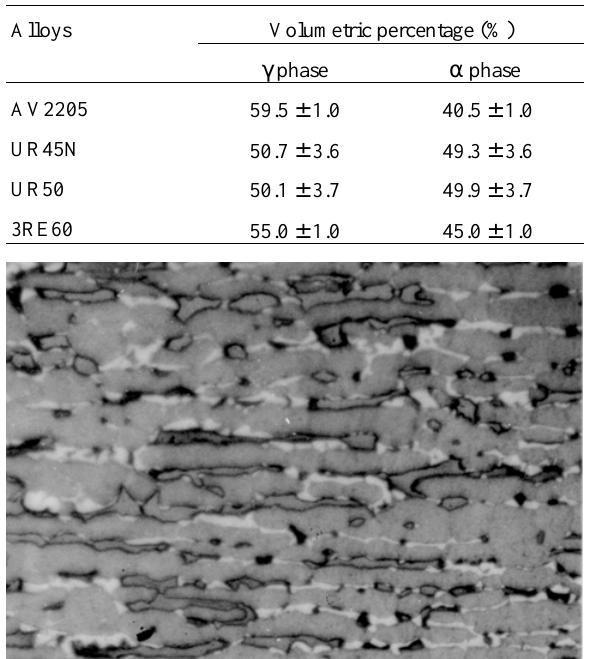
Figure 2. Microstructure of the AV2205 alloy after heat treatment at 850 °C for 1 h. White: sigma phase; continuous gray: austenite; dispersed gray: ferrite. 811X.